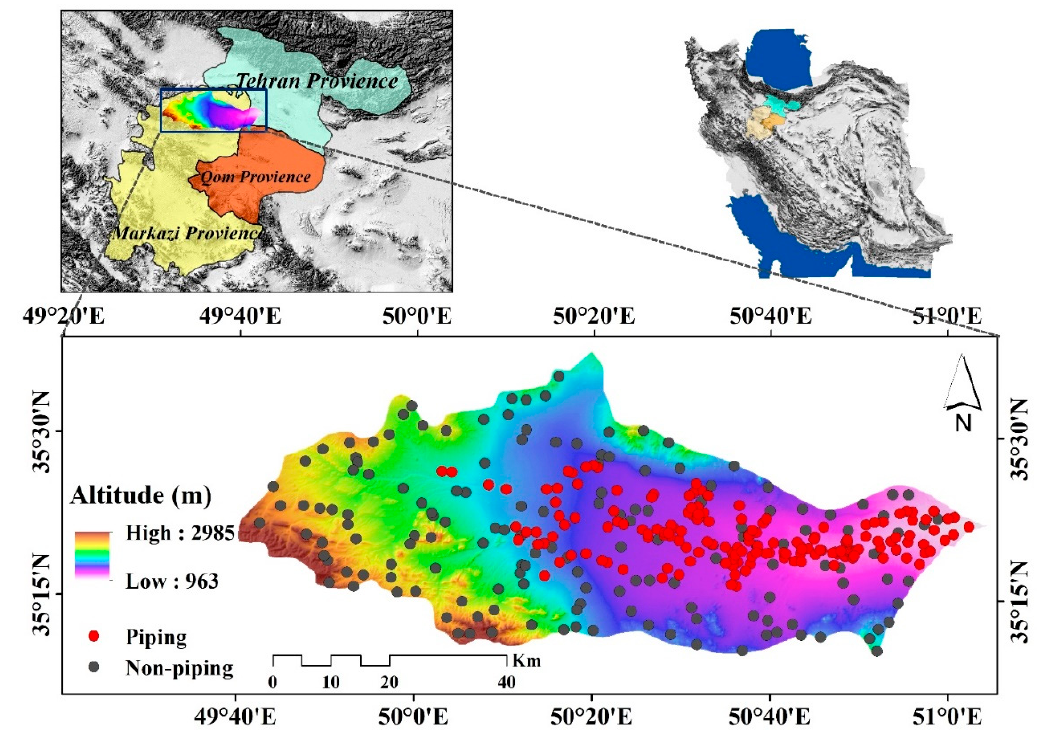
Figure 1. Location of Zarandieh Watershed in Iran.